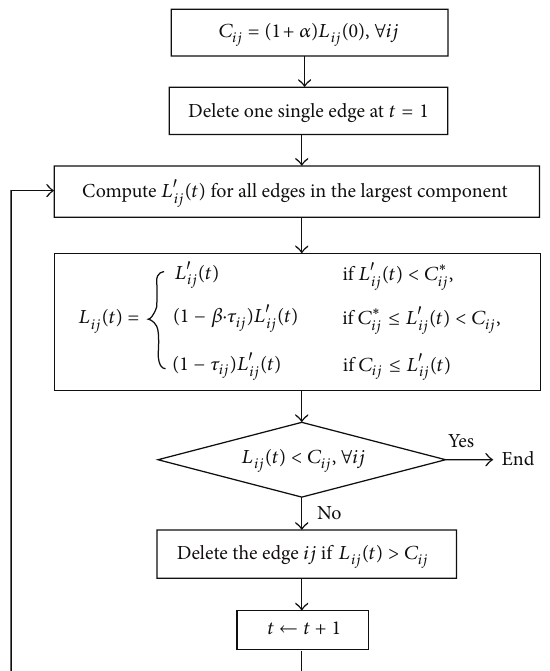
Figure 1: The evolving procedure of cascading failures in networks with the external resource 𝜏